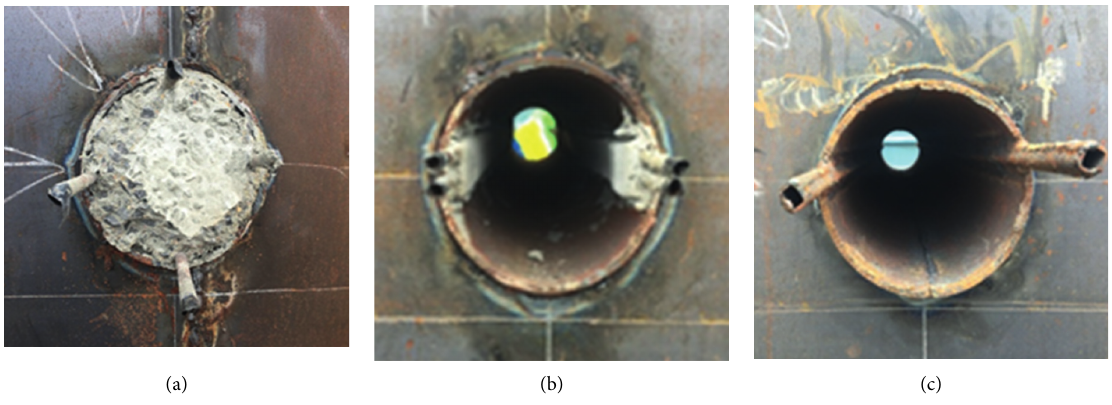
Figure 4: Pipe jacking layout drawing: (a) SCF; (b) EDCF; (c) ESF. Table 2: Properties of the test